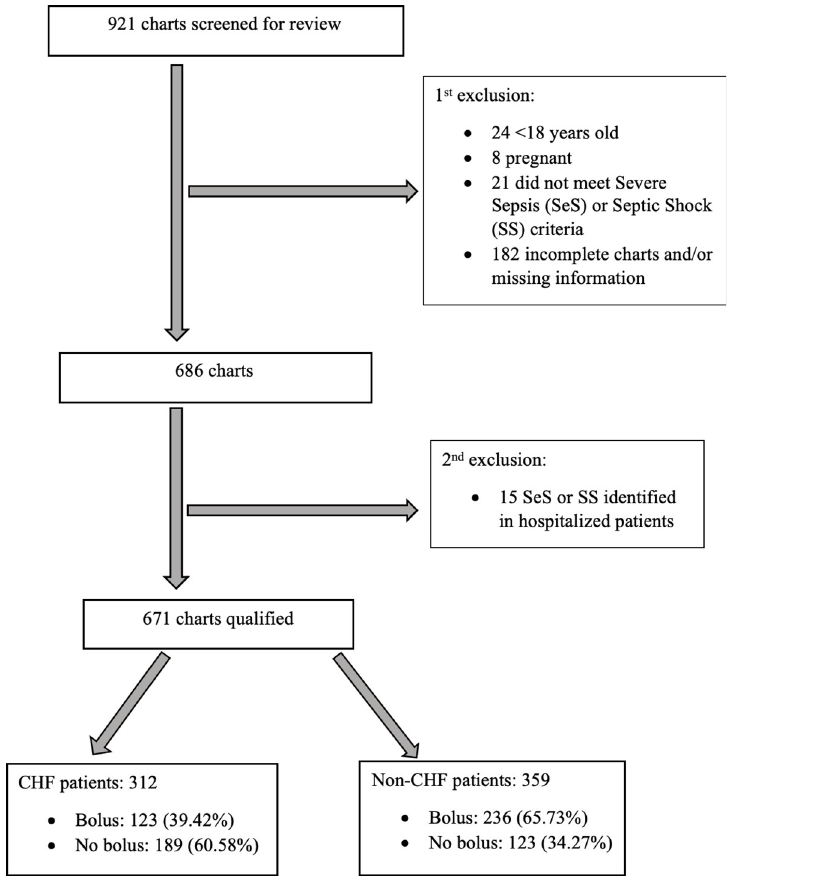
Fig 1. Flow diagram of eligible patient selection. CHF = Congestive Heart